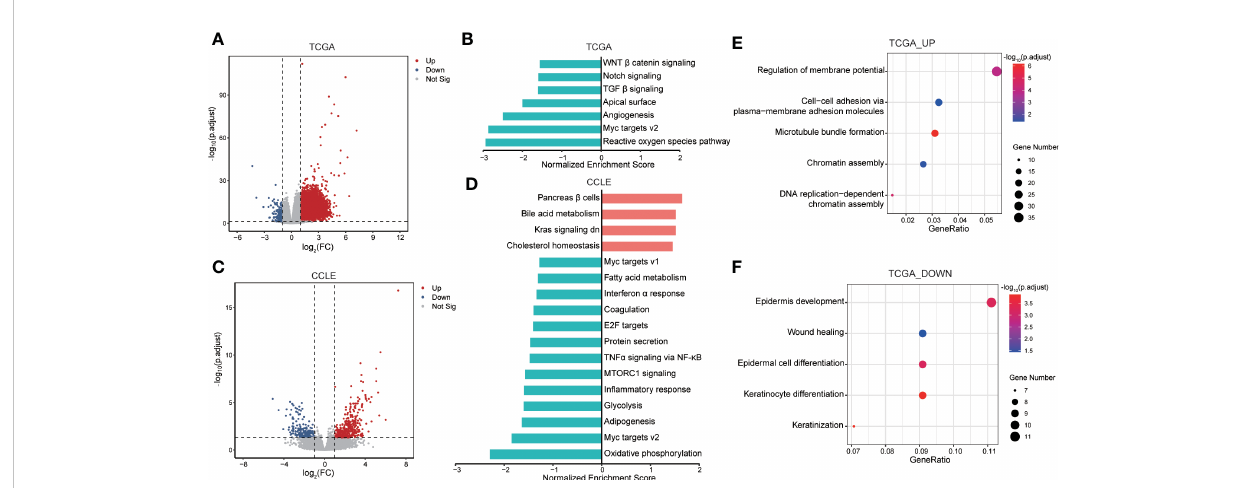
FIGURE 4 Functional enrichment analysis for prognosis signature. (A) Volcano plot showing DEGs between groups with high IRAK1BP1 expression and low IRAK1BP1 expression in TCGA-LUAD primary tumor samples. Red indicates elevated expression while blue indicates reduced expression (down). (B) GSEA enrichment analysis identi fi ed down-regulated oncogenic pathways in samples with high IRAK1BP1 expression relative to the group with low IRAK1BP1 expression in TCGA-LUAD cohort. (C) Volcano plot showing DEGs between groups with high IRAK1BP1 expression and low IRAK1BP1 expression in LUAD cell line of CCLE database. Red indicates elevated expression while blue indicates reduced expression (down). (D) GSEA enrichment analysis identi fi ed down-regulated oncogenic pathways in samples with high IRAK1BP1 expression relative to the group with low IRAK1BP1 expression in lung cancer cell lines in CCLE database. (E) GO analysis of up-regulated genes in the group with high IRAK1BP1 expression in TCGA-LUAD. (F) GO analysis of down-regulated genes in the group with high IRAK1BP1 expression in